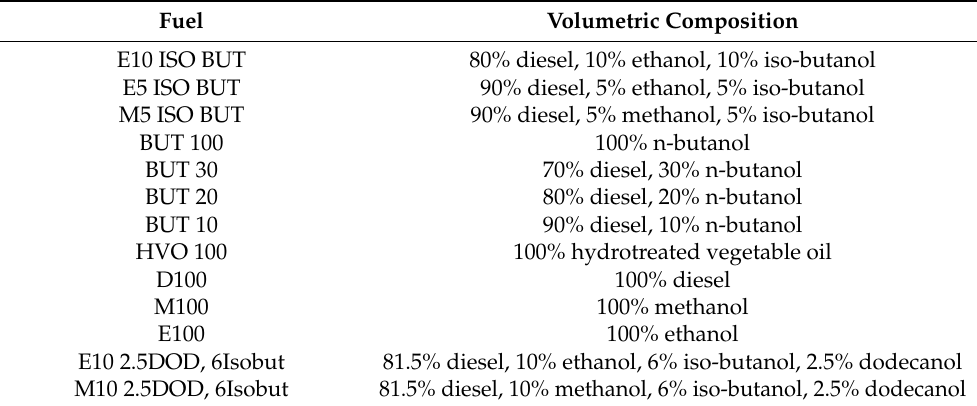
Table 2. Pure and blended tested